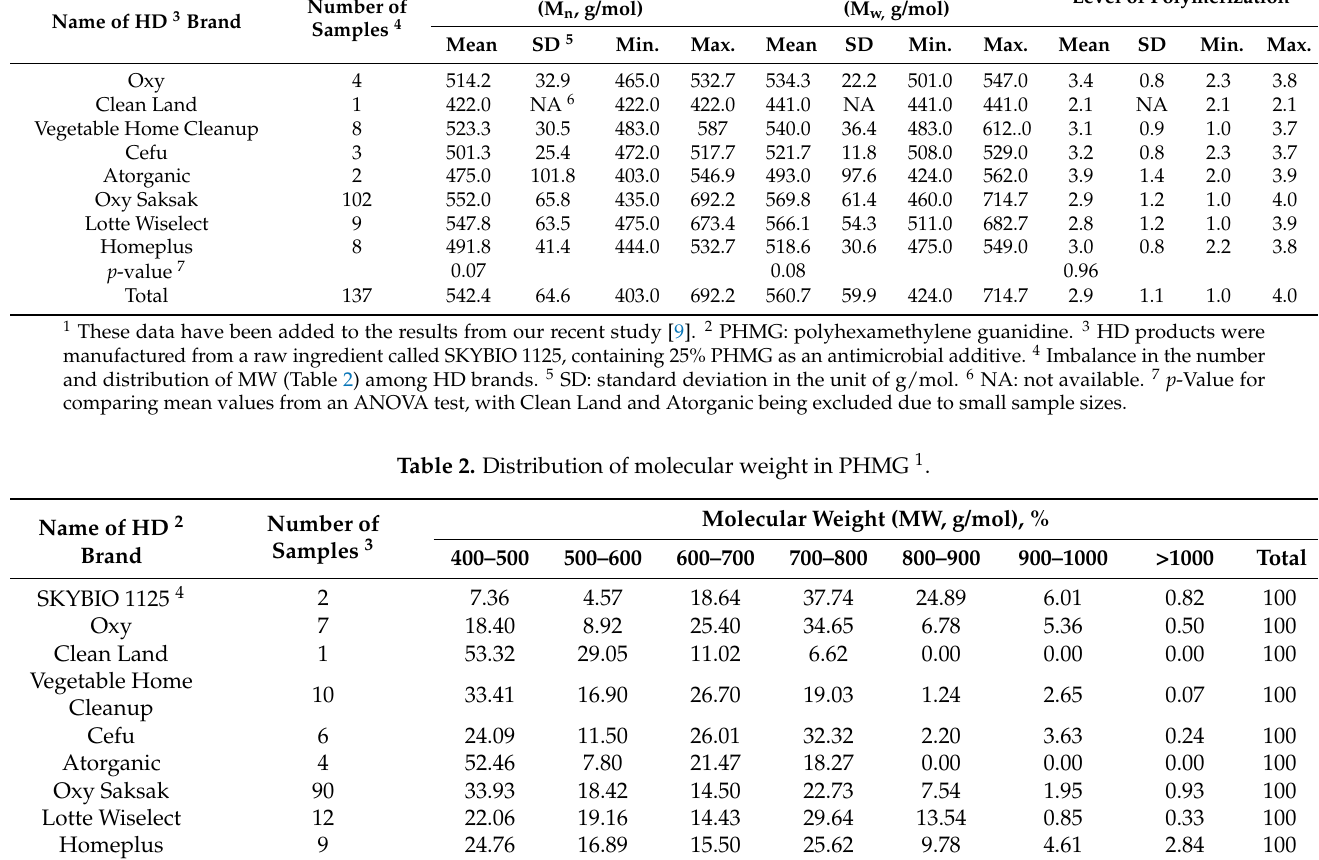
Figure 1. Structures of four isomeric types of PHMG oligomers in HD products, as identified in the MALDI ‐ TOF MS spectra. Figure 2. Distribution of molecular types of polyhexamethylene guanidine (PHMG) among types of humidifier disinfect ‐ ant products.